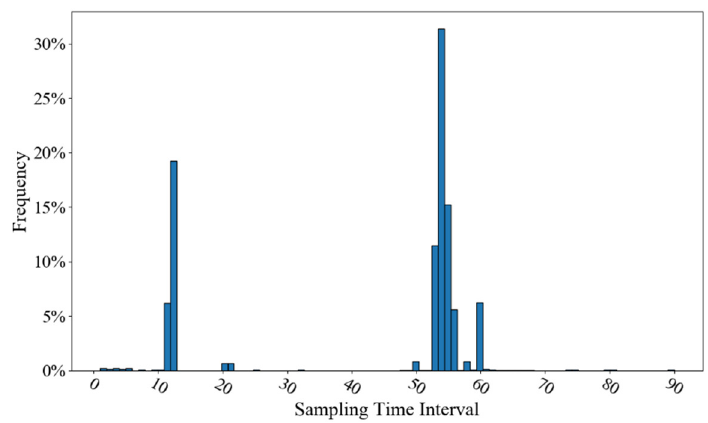
Figure 5. Sampling time intervals of the dataset.